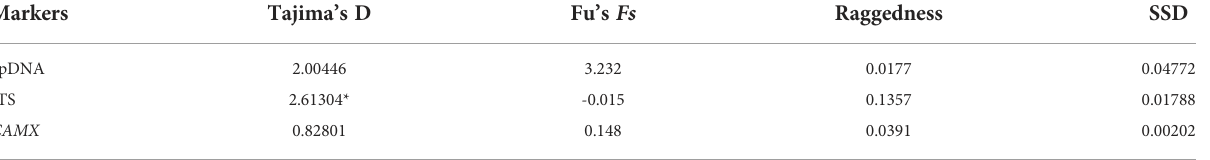
TABLE 3 Parameters of neutrality tests and mismatch analysis (*P<0.05).